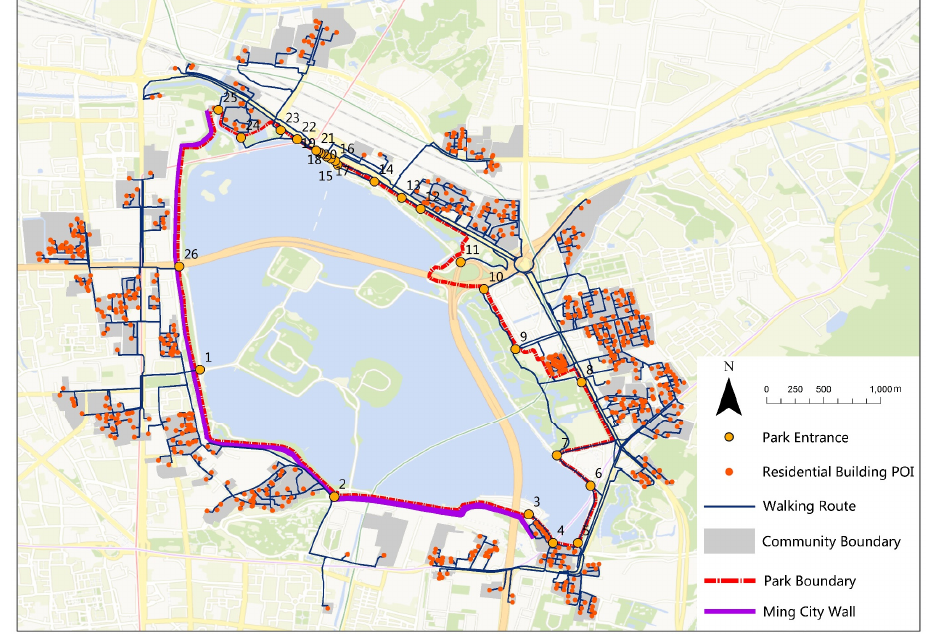
Figure 1. Fifteen-minute walking routes that define Xuanwu Lake Park’s pedestrian shed (base map from Tianditu